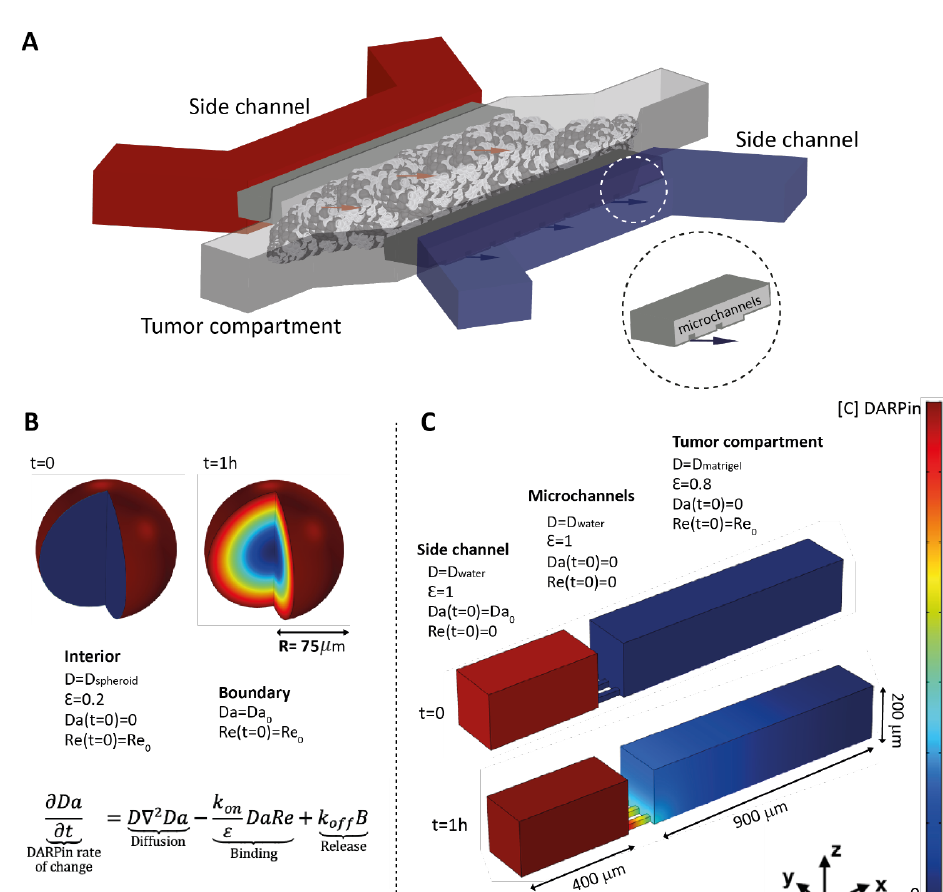
Figure 1. Overview of the tumor-on-a-chip system and conditions for the mathematical model in spheroids and on-chip. ( A ) Illustration of the microfluidic tumor-on-a-chip system showing the side channels used for DARPin delivery towards the tumor channel, where tumor cells or tumor cells and fibroblasts together grow embedded in Matrigel. The insert shows a close-up view of the microchannels that connect the side channels of the tumor compartment. ( B ) Spheroids were modelled in COMSOL as spheres into which the free DARPins (Da) diffused from outside to inside, while encountering receptors on the surface of the cells (Re). The model was simplified into a 1D model using the spherical expression of Equation (1) (see Material and Methods). B refers to DARPin–receptor complex. ( C ) The tumor-on-a-chip 3D geometry was reproduced in COMSOL. DARPins diffuse from the side channel to the tumor compartment, which is connected by small microchannels. The matrix properties and cell density were taken into account by implementing distinct diffusion coefficients (abbreviated as D water and D matrigel ) and available volume (void) fractions (ε) for the tumor compartment and for the side channel.